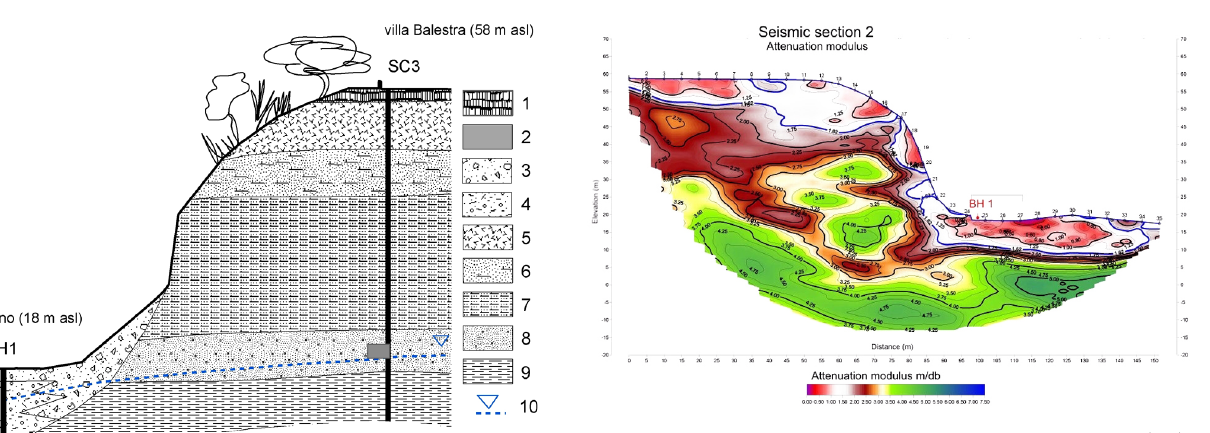
Fig. 8. Seismic survey, section 2. Compression wave velocity